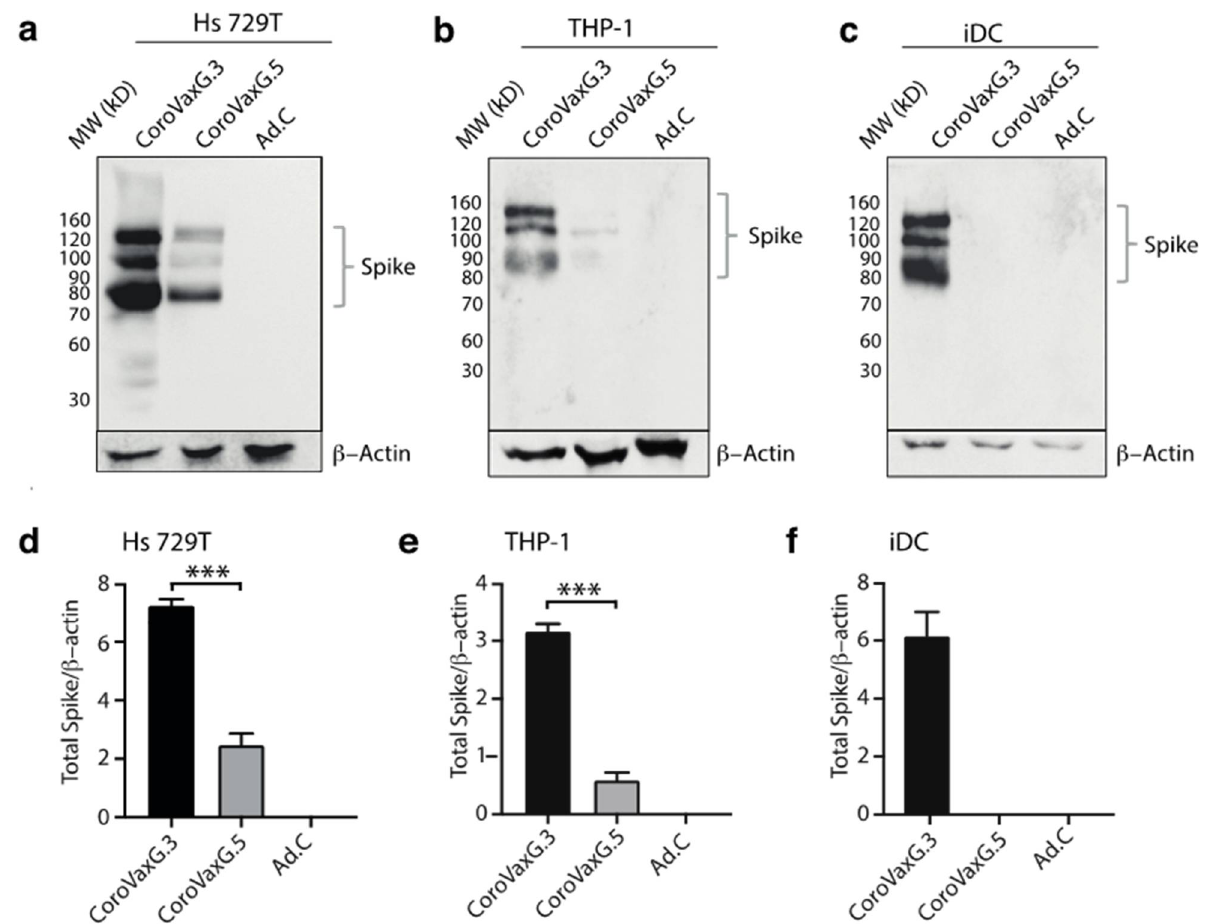
Figure 2. Spike expression following in vitro transduction with AdV-vectored vaccines. ( a – c ) WB assay performed on Hs 729T, THP-1 and immature dendritic cells (iDC) after 48 h of transduction with CoroVaxG.5, CoroVaxG.3 and control Ad.C. Spike expression was detected using an anti-Spike antibody. β-actin was used as a loading control. ( d – f ) The bar graphs represent a semi-quantification of the WB assay normalized by β actin. *** p < 0.001; one-way ANOVA.